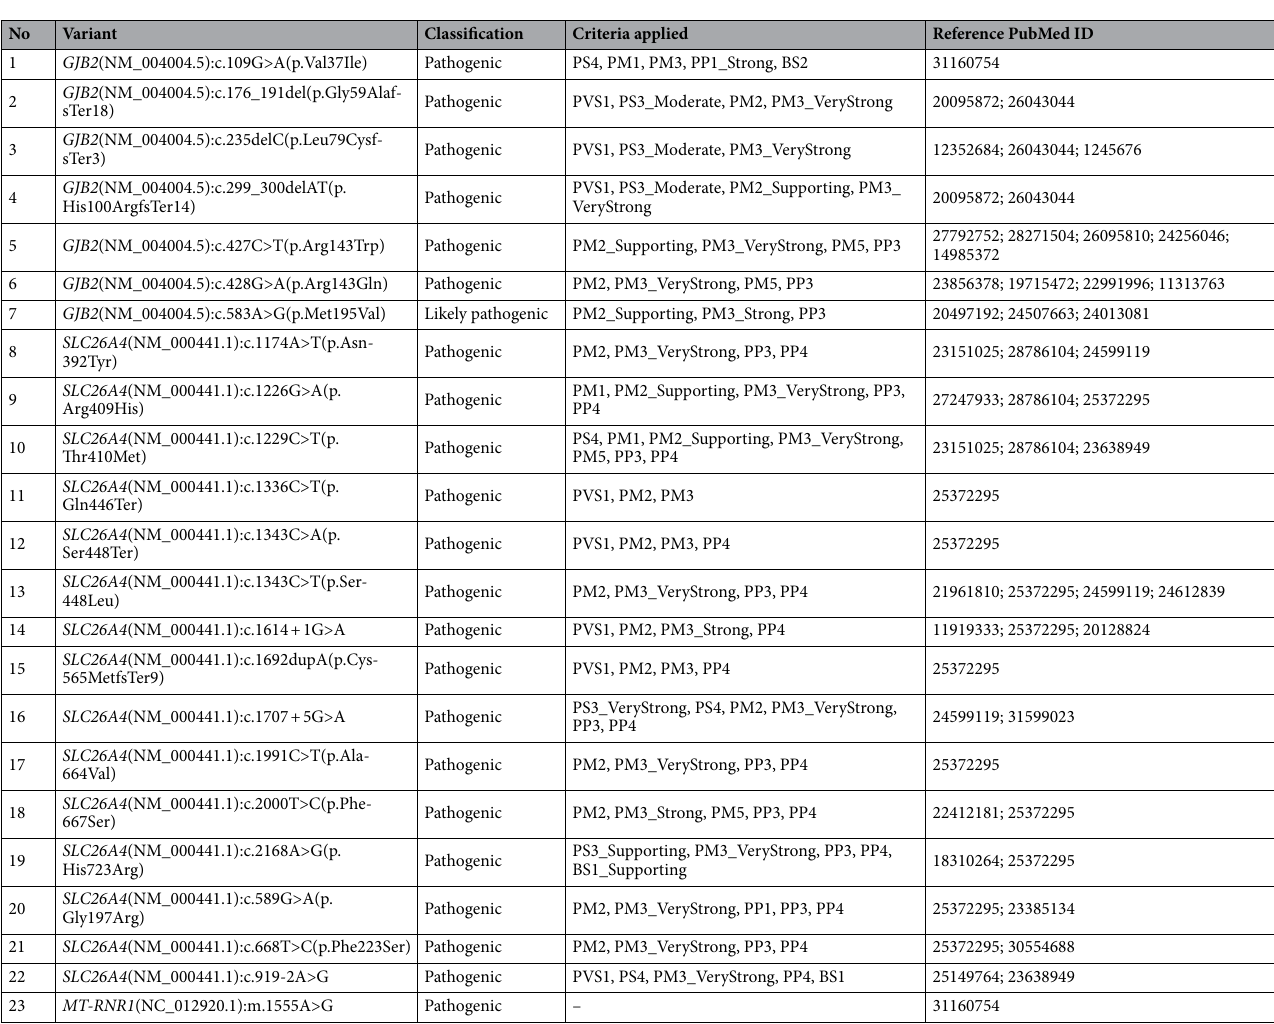
Table 3. Classification of variants detected in first